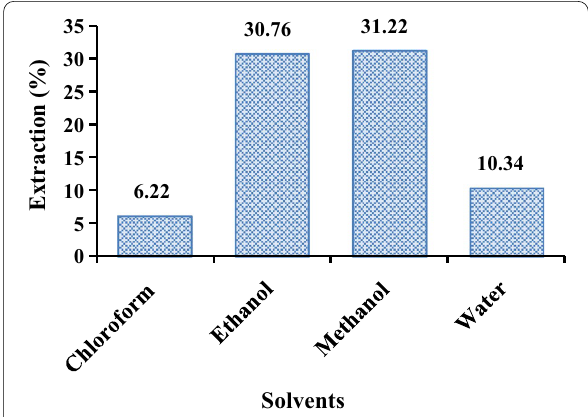
Fig. 2 Extraction percentage of tannin by different solvents